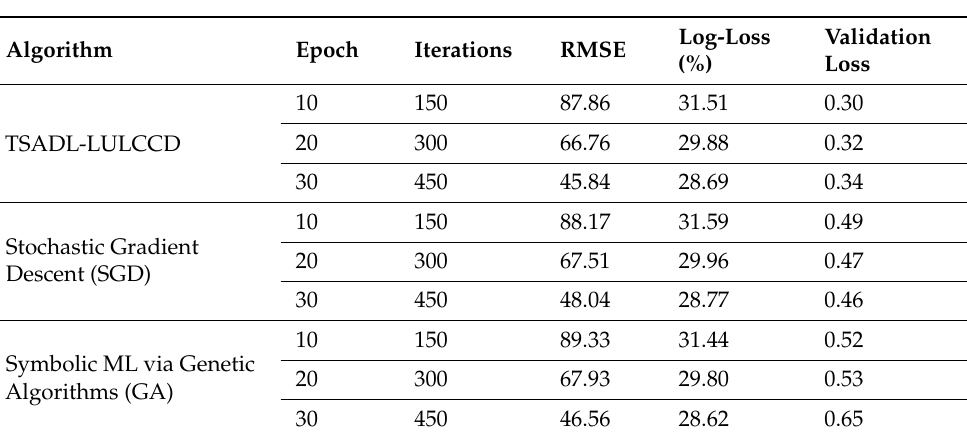
Table 6. Training and Validation process results.